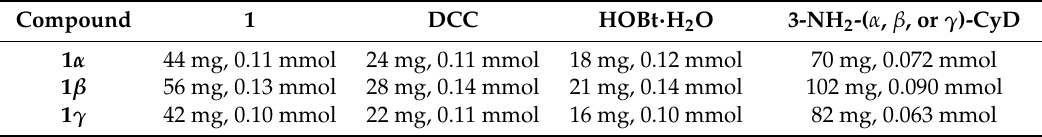
Table 1. The reagents used to synthesize 1 α , 1 β , and 1 γ